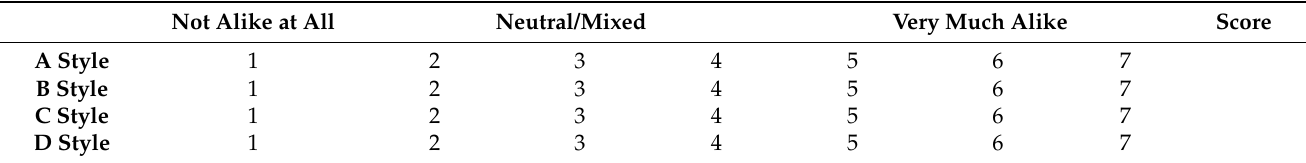
Table A2. Match to